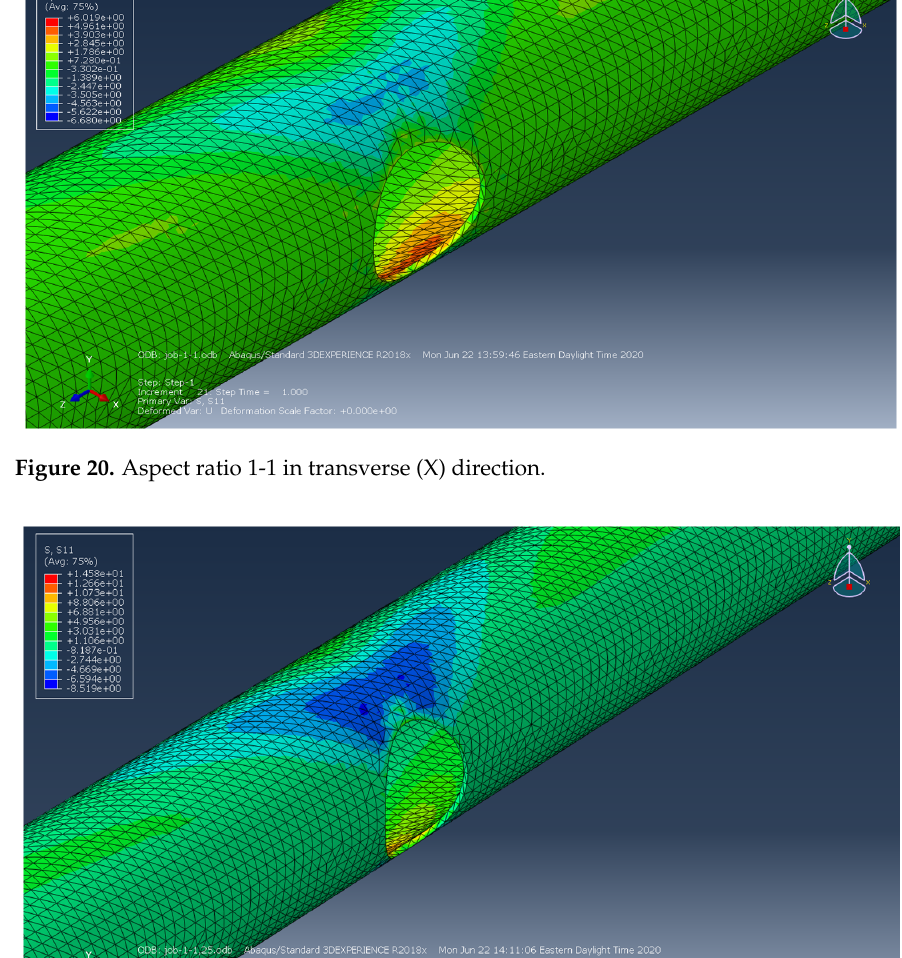
Figure 21. Aspect ratio 1-1.25 in transverse (X) direction.